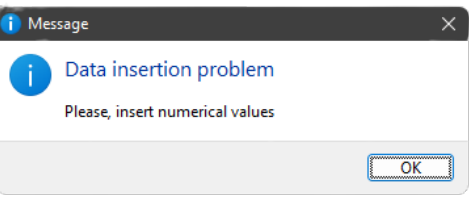
Figure 15. Invalid input error message.